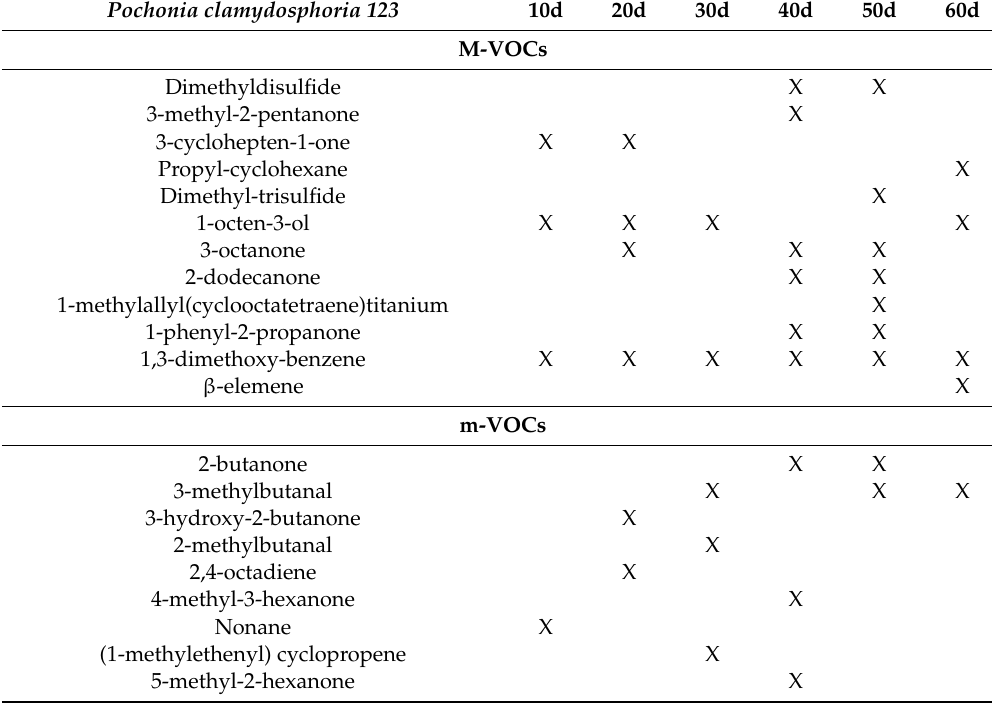
Table 5. M-VOCs and m-VOCs produced by P. clamydosphoria 123 during 60 days of growth. Abbreviations: VOC = volatile organic compound, M-VOCs = major VOCs, m-VOCs = minor VOCs, d = days after